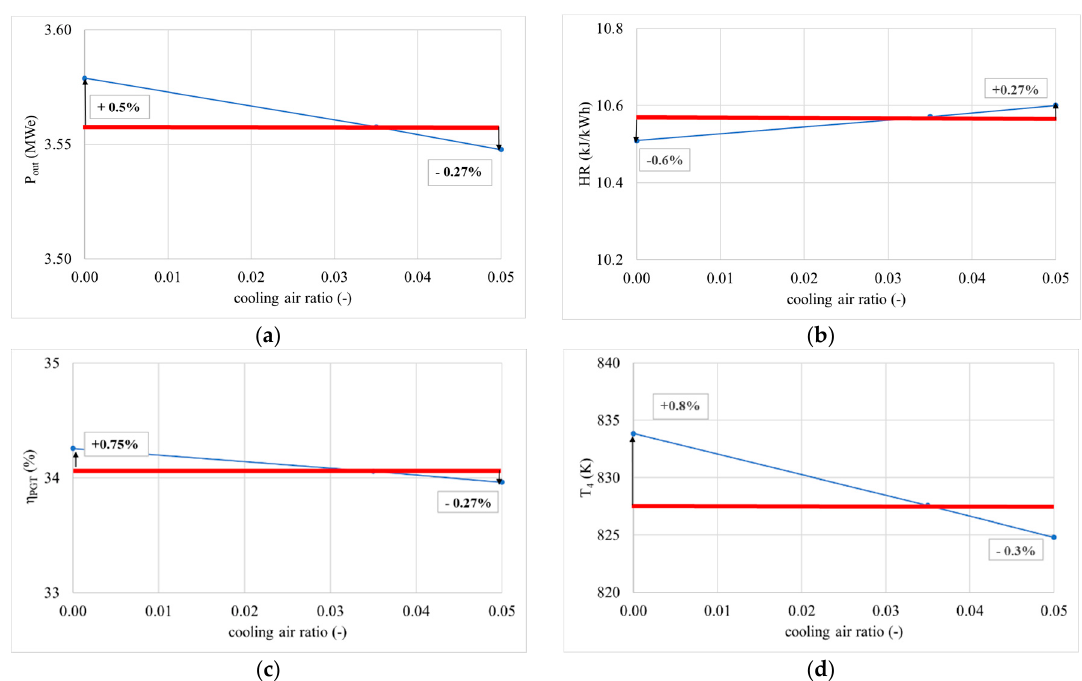
Figure 13. Change of gas turbine cycle outlet parameters in function of cooling air ratio ( a ) power change in function of cooling air ratio, ( b ) heat rate change in function of cooling air ratio, ( c ) gas turbine plant e ffi ciency change in function of cooling air ratio and ( d ) change of temperature of the expanded products at the gas turbine outlet in function of cooling air ratio.